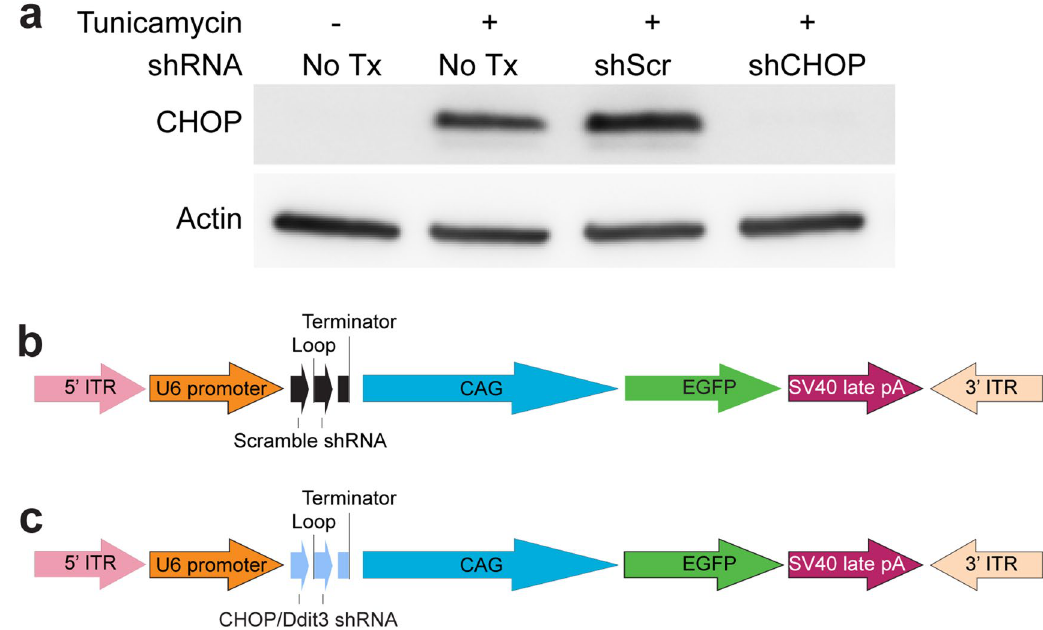
Figure 1. Validation of shRNA plasmid knockdown of CHOP in HT22 hippocampal cells. ( a ) Western blot of HT22 cell lysates that were transfected with non-targeting (Scramble) or CHOP-targeting shRNA for 72 h. To induce ER stress, tunicamycin was added to the media 24 h before harvesting. ( b ) Schematic of shScramble (shScr) and ( c ) shCHOP viral constructs. Ddit3, DNA Damage-Inducible Transcript 3—gene encoding CHOP. CHOP CCAAT-enhancer binding protein homologous protein, EGFP enhanced green fluorescent protein, shRNA short hairpin RNA, Tx treatment. Uncropped blots are provided in the Supplemental Information Fig.